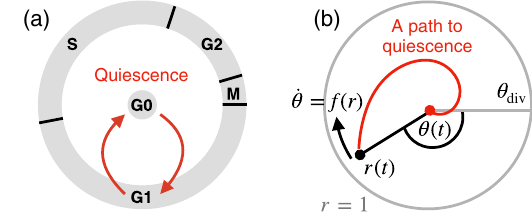
FIG. 1. Two representations of the cell cycle. Panel (a) shows a typical biologist ’ s illustration of the cell cycle, with sequential phases M, mitosis; G1, gap (or growth) 1; S, synthesis (of DNA); G2, Gap 2; and G0, gap 0 (quiescence), a resting state, off the main cycle, in which cells do not divide. Cells undergo mitosis and divide at the end of M phase. The proliferation-quiescence switch is controlled by mechanical stress and other microenvir- onmental factors. (b) A representation of the cell-cycle model studied here. The phase of the cell cycle is parametrized by an angle θ with a parameter r a proxy for cell-cycle activity, represented by a radial distance. The dynamics of r are controlled by a separate equation that is sensitive to physical stresses [see text and Eq. (2)]. Unstressed, the cell cycle orbits around the circle r ¼ 1 in a space that can be thought of as a proxy for the biochemical or genetic concentrations, dividing every τ when div θ ¼ θ ¼ 2 n π with n ∈ Z , just like in (a). The red line div represents a (reversible) transition between a proliferating state and full quiescence at r ¼ 0 with the rate of progress around the cycle f ð r Þ a decreasing function of activity r , reflecting slowing of the cell